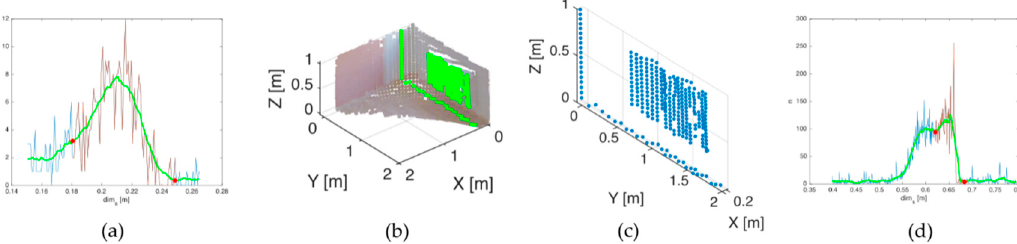
Figure 22. Fine planar surface range estimation: ( a ) Points histogram in the scanning dimension with marked thinner range; ( b ) Thinner range selection in the comparison with Figure 10a,b; ( c ) Selected points by this range; ( d ) Illustration of the problematic case.